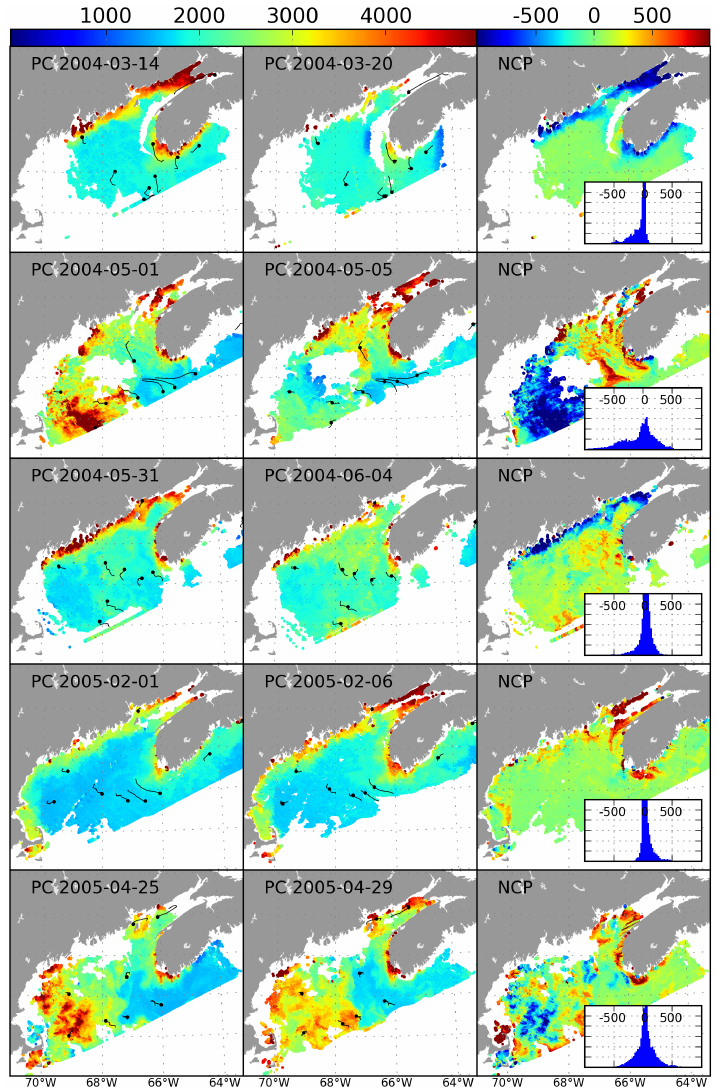
Fig. 3. The growth/consumption of PC (mmolm − 2 d − 1 ) is diagnosed in the reference frame of moving water parcels. PC from the first image at time t 1 in the left panels is interpolated onto virtual particles whose trajectories are calculated using velocity fields from a circulation model until the time t 2 of the next satellite image, 4 days later. Each virtual particle, now advected to a new position, finds the value of PC that it should have from the second satellite image. This is plotted in the middle panels at the starting location occupied by the particle. Black lines represent individual trajectories and black dots the position of the particles at the time of the satellite image. The difference, in the right panels, is the net change in PC along-trajectory. For each trajectory, we apply the Chl:C model to derive the net rate of growth/consumption of PC. and then plot the result at the beginning of each trajectory, creating the NCP e map. The histograms show the distribution of NCP e from all trajectories in each event. The median of all NCP e values at a given time constitutes each data point of the time series shown in Fig. 5. 8